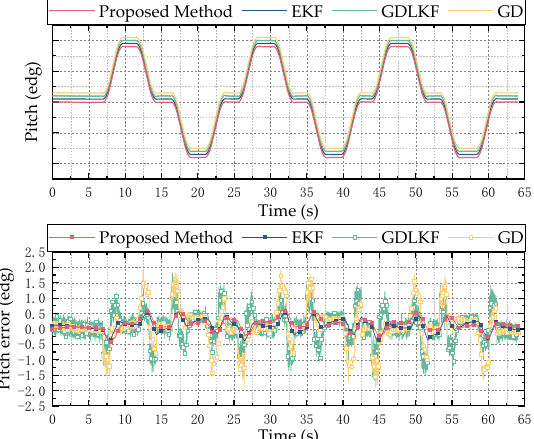
Figure 11. Hardware-in-the-loop simulation test results of pitch angle. The above is a comparison of the estimation results of different methods, and the bottom is the error between the estimated value of different methods and the reference value.